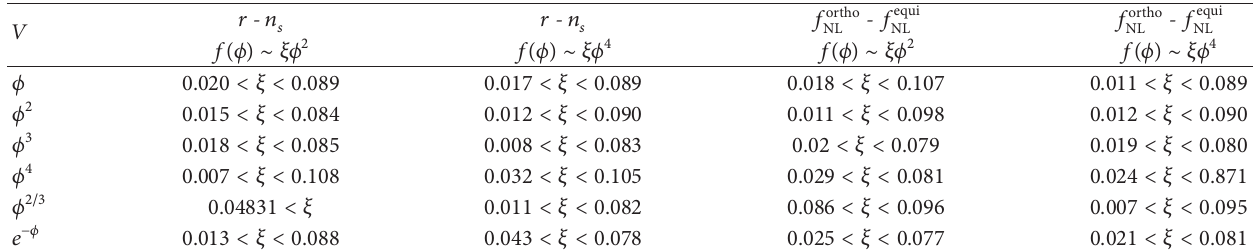
Table 3: The ranges of 𝜉 in which the values of the inflationary parameters 𝑟 and 𝑛 𝑠 and also 𝑓 ortho NL and 𝑓 equi NL , with 𝑛 = 3 , are compatible with the 95 % CL of the Planck 2015 dataset.